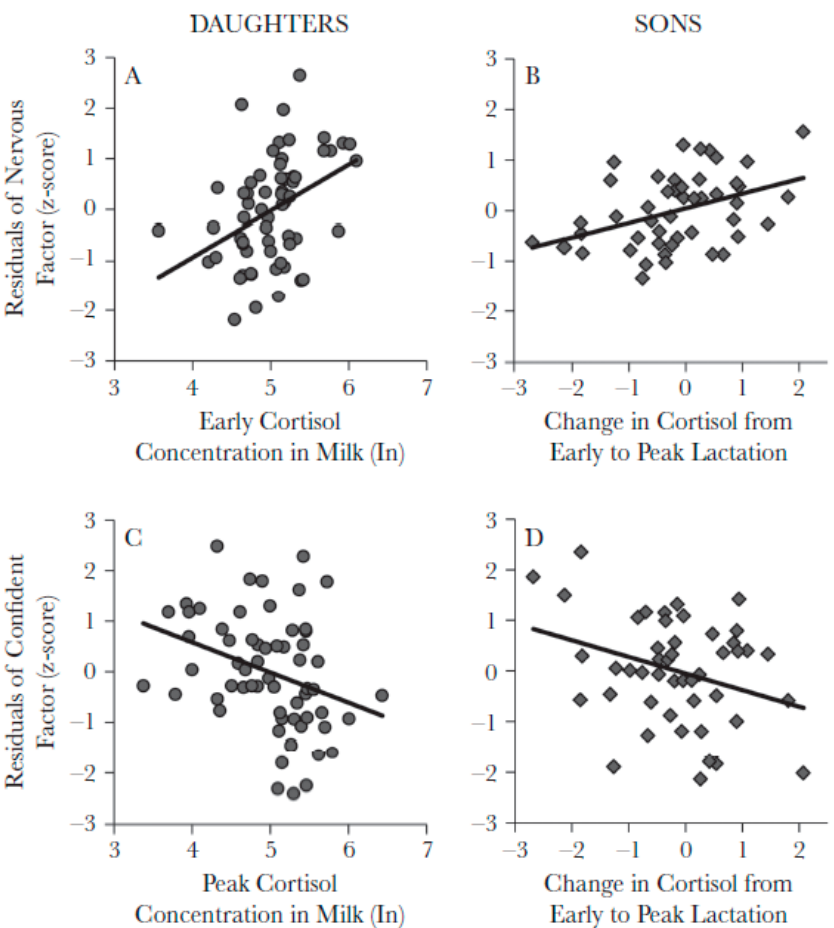
Figure 4. Milk cortisol concentrations and temperament. For daughters, cortisol concentrations during early ( A ) and peak ( C ) lactation are associated with Nervous and Confident temperaments, respectively. For sons, the change in milk cortisol concentrations from early to peak lactation was associated with Nervous ( B ) and Confident ( D ) temperaments. Reprinted from [45].